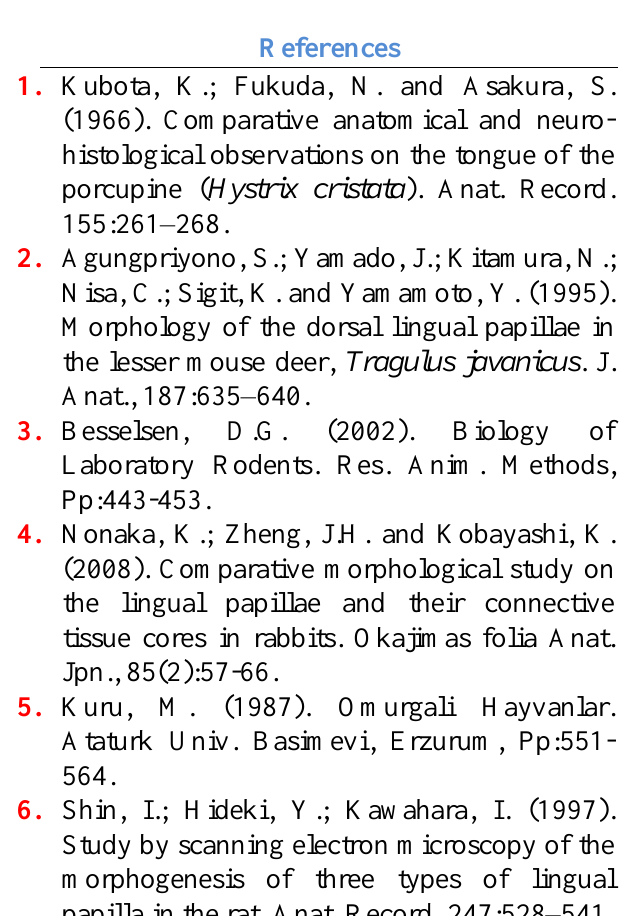
Figure, 8: Foliatepapillae of tongue Hystrix crestate show: mucosa (1) submucosa (2) muscular layer (3) taste bud (4) (H and E) stain 400